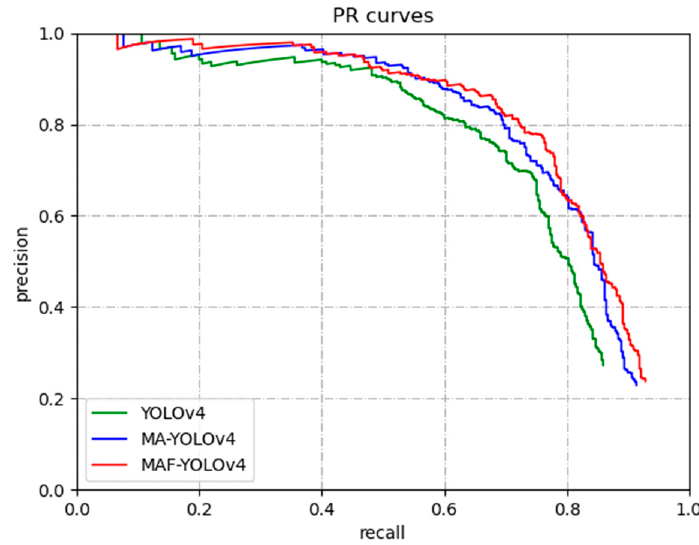
Figure 11. PR curve for detection models.